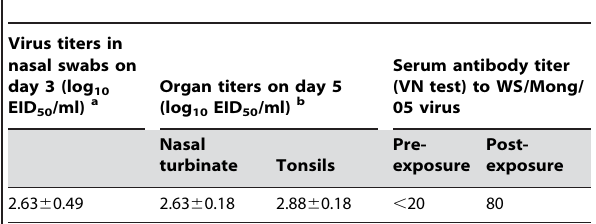
Table 3. Exposure of pigs to WS/Mong/05 H5N1 virus through consumption of meat from infected chickens